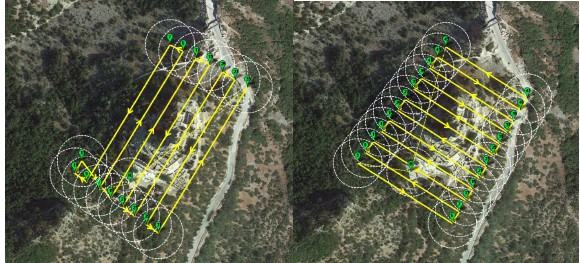
Figure 3 a. Flight plans and camera configuration: